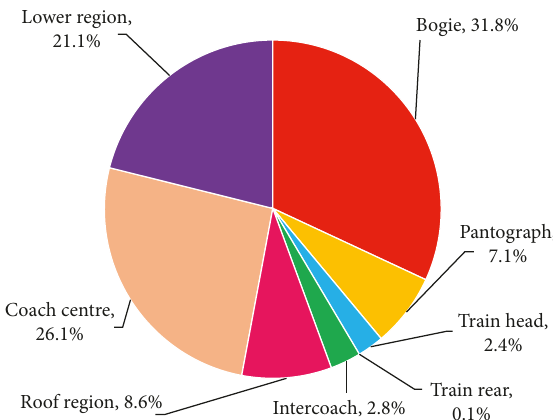
Figure 8: Contribution rate of the exterior sound sources to the total sound power (350